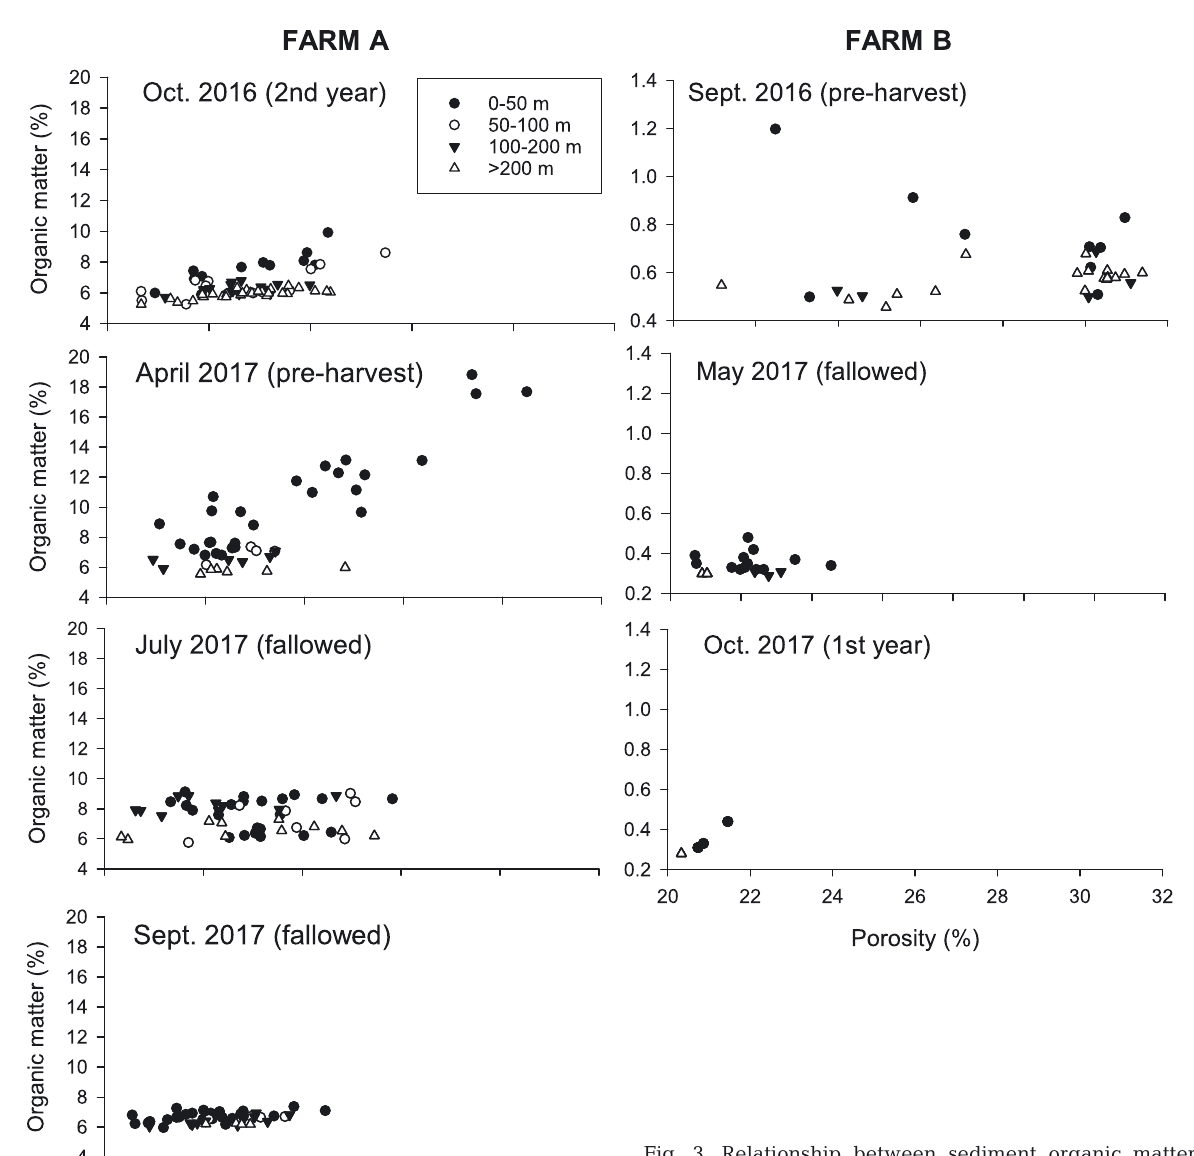
Fig. 3. Relationship between sediment organic matter content and porosity at Farm A and Farm B during differ- ent seasons and husbandry stages. Symbols represent the distance range in which each core sample was